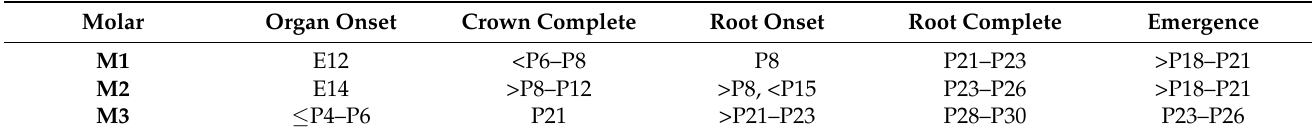
Table 2. Stages of earliest radiographically visible tooth organ onset, crown completion, root onset and completion, and tooth emergence for the first (M1), second (M2) and third (M3) molars of both the upper and lower jaws. Abbreviations: –, to/between; <, earlier than; >, later than; ≤ , earlier or at.